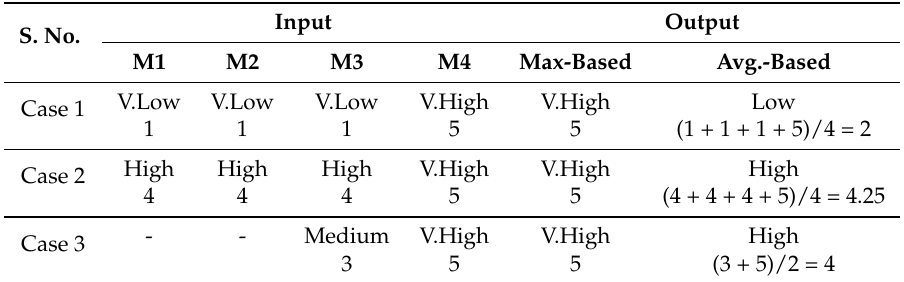
Table 2. Example cases for illustration of rules definition using average and maximum based